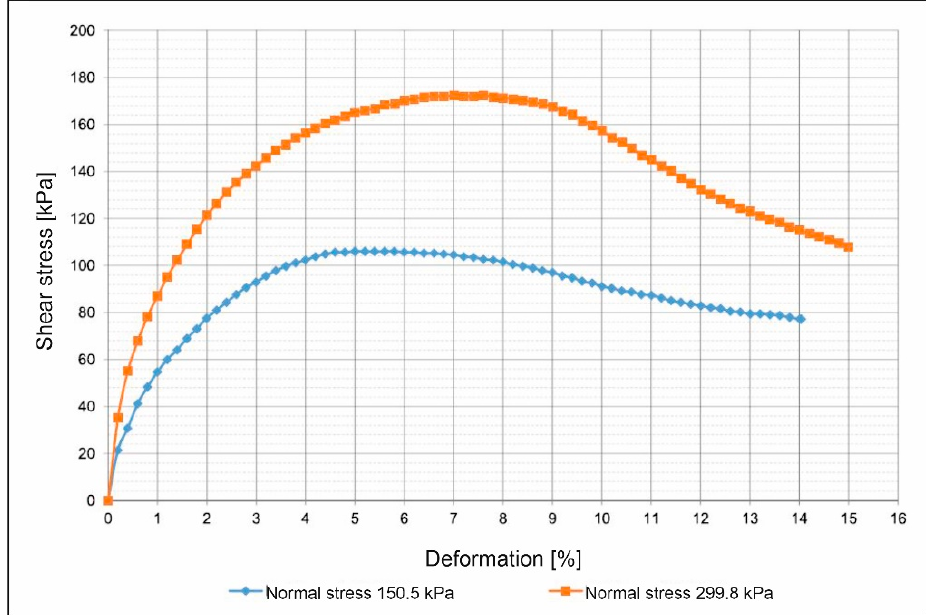
Figure 11. Shear-displacement curves.